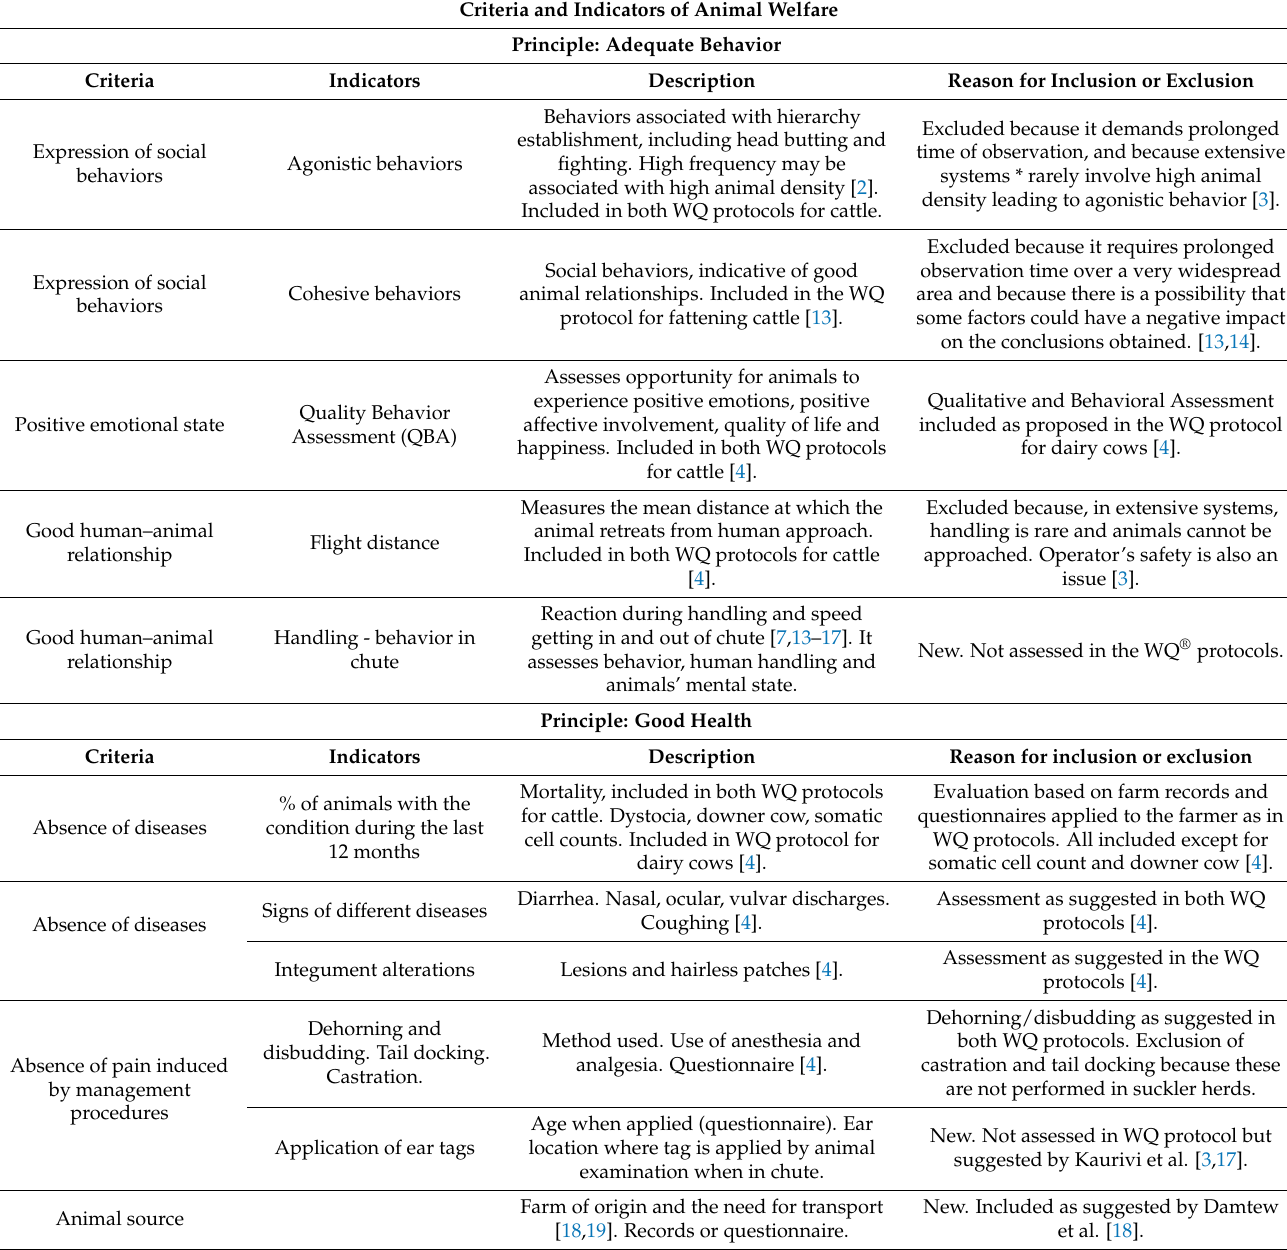
Table 1. Criteria and indicators used in the current study, based on the Welfare Quality ® assessment protocol for cattle [4], as well as the reason for new inclusions or